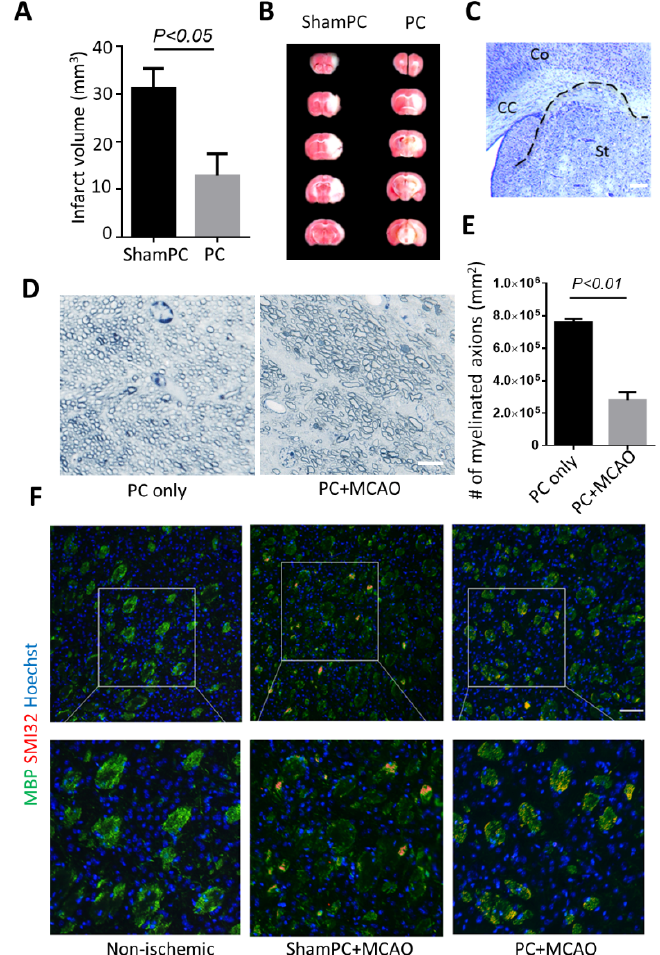
Figure 1. Preconditioning attenuates ischemic injury in the cortex but not the striatum. ( A ) Quantitative analysis of ischemic area based on TTC staining. ( B ) Photomicrographs of infarct areas stained with TTC in shamPC and PC group. ShamPC, mice received sham preconditioning (i.e., without preconditioning treatment); PC, mice received 3 min of MCA occlusion as preconditioning. ( C ) Demonstration of tissue swelling in a representative mouse subcortical white matter 7 days after stroke. CC indicates corpus callosum; Co, cortex; and St, Striatum. ( D ) Toluidine blue staining of cross sections of the corpus callosum. Bar, 5 μ m. ( E ) Fewer myelinated axons were observed in PC + MCAO group. ( F ) Representative immunofluorescence microscopic analyses of MBP (green) and SMI-32 (red) in shamPC and PC group after MCAO. MBP with diffuse distribution and abnormally dephosphory- lated neurofilament SMI-32 could be detected in both preconditioning/non-preconditioning-treated striatum. Results shown represent mean ± SD, n = 5–7. Bar, 100 µ